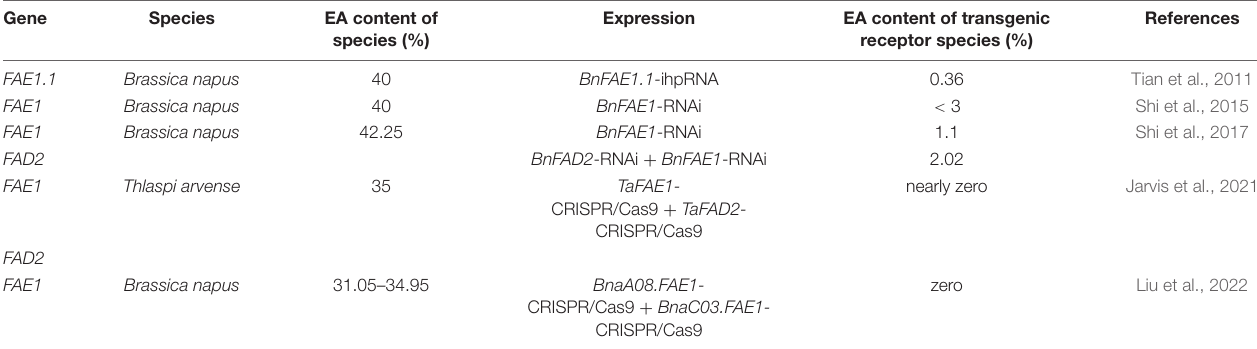
TABLE 3 | Comparison of research on decreasing EA content by means of genetic engineering in Brassicaceae